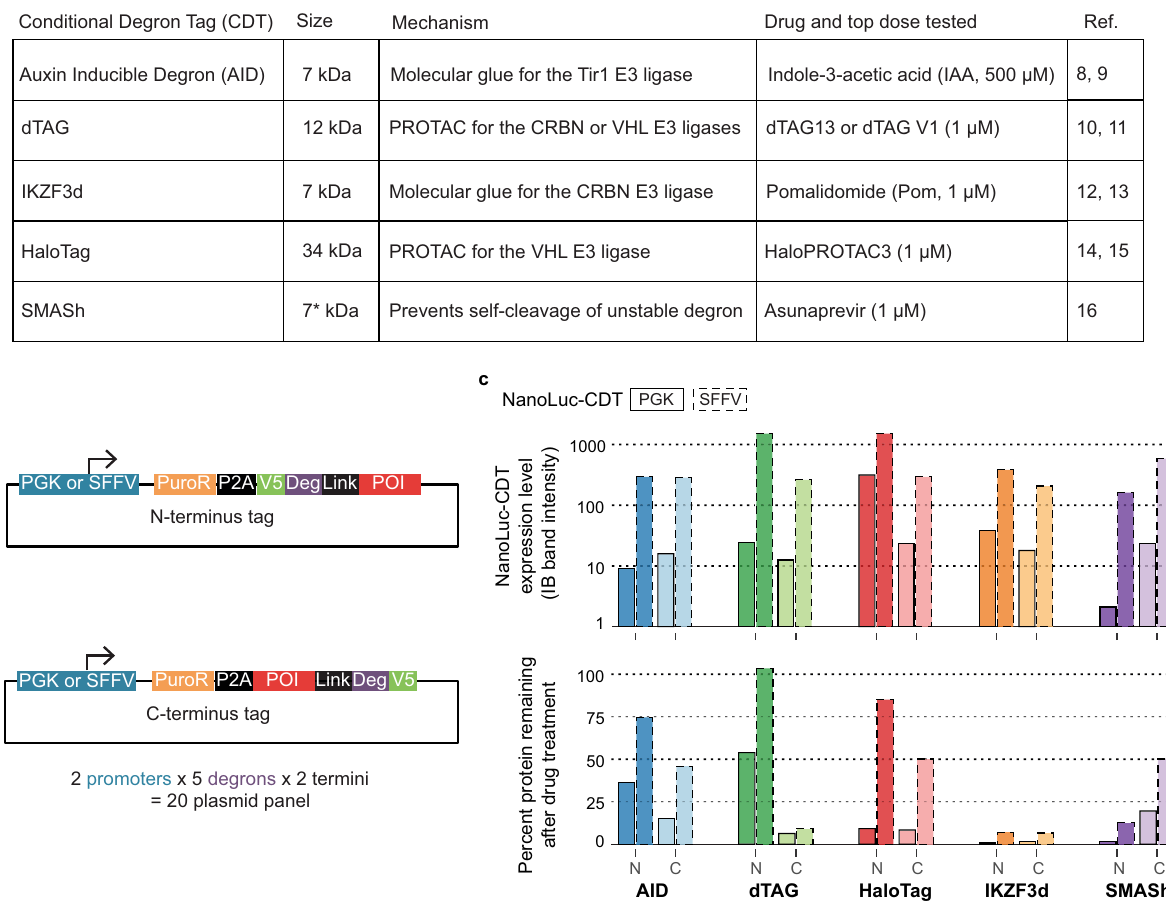
wasalsoincorporatedbetweenthedegrontagandthecloningsiteinallconstructs except AID and SMASh, where the CDT is separated from the POI by the V5 tag. These expression cassettes were cloned into a lentiviral vector for stable integra- tion into the genome. c Validation of the CDT panel using NanoLuciferase. Nano- Luciferase fused to the indicated CDT was expressed using the PGK or SFFV plasmids. Here, expression levels are reported as the anti-V5 IB band intensity normalized to the anti-Vinculin band intensity and then scaled to the total expressionofalltenCDTsevaluatedtohighlighttherelativeexpressiondifferences between the different CDTs. Degradation is reported as the percent reduction in theanti-V5IBbandintensityafterdrugtreatment.SeeSupplementaryFig.2aforthe full IB for both PGK and SFFV